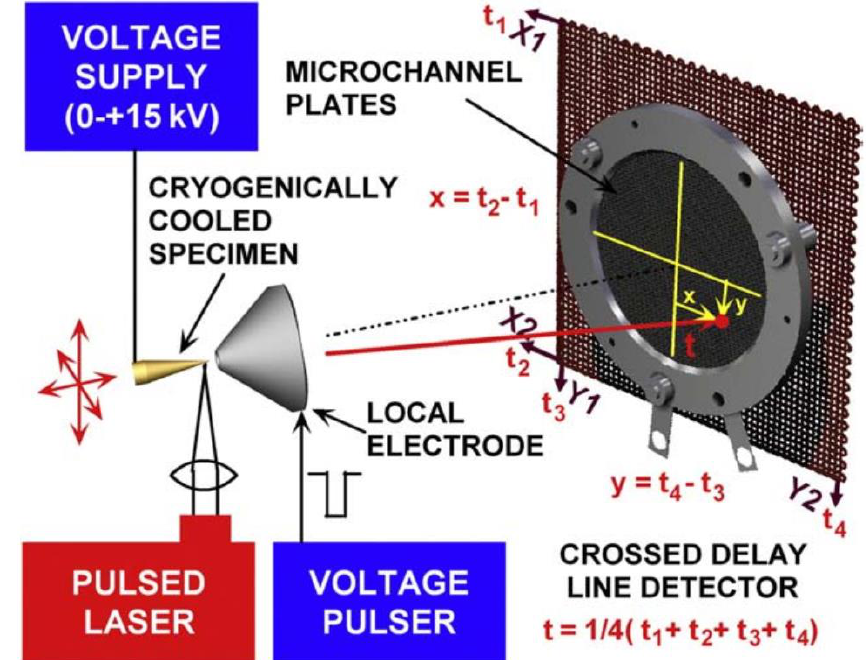
Figure 1. Schematic principle of the atom probe tomography with the specimen tip facing a position-sensitive detector. The evaporation of the specimen can be initiated by voltage or laser pulses. Reprinted from [74], Copyright (2009), with permission from Elsevier.